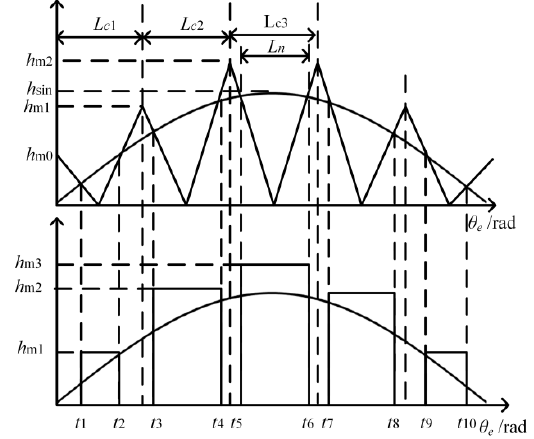
Figure 2. Unequal amplitude modulation.